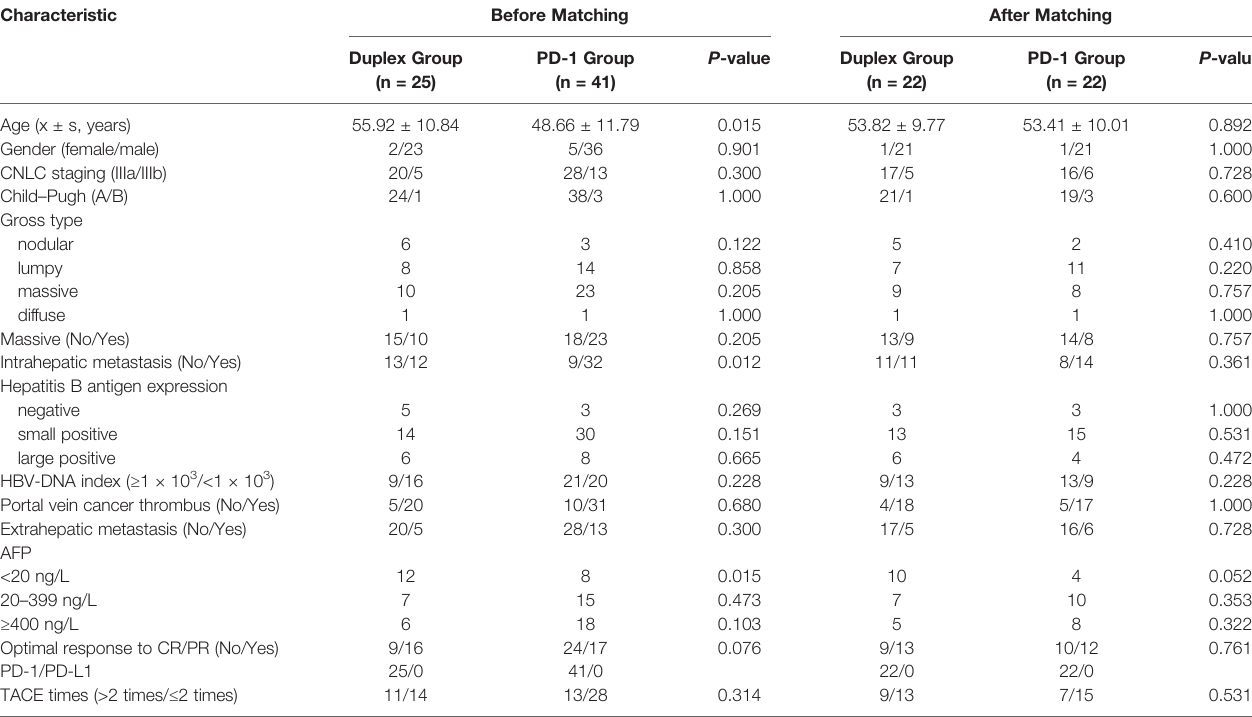
TABLE 1 | Baseline characteristics of all study patients. Characteristic